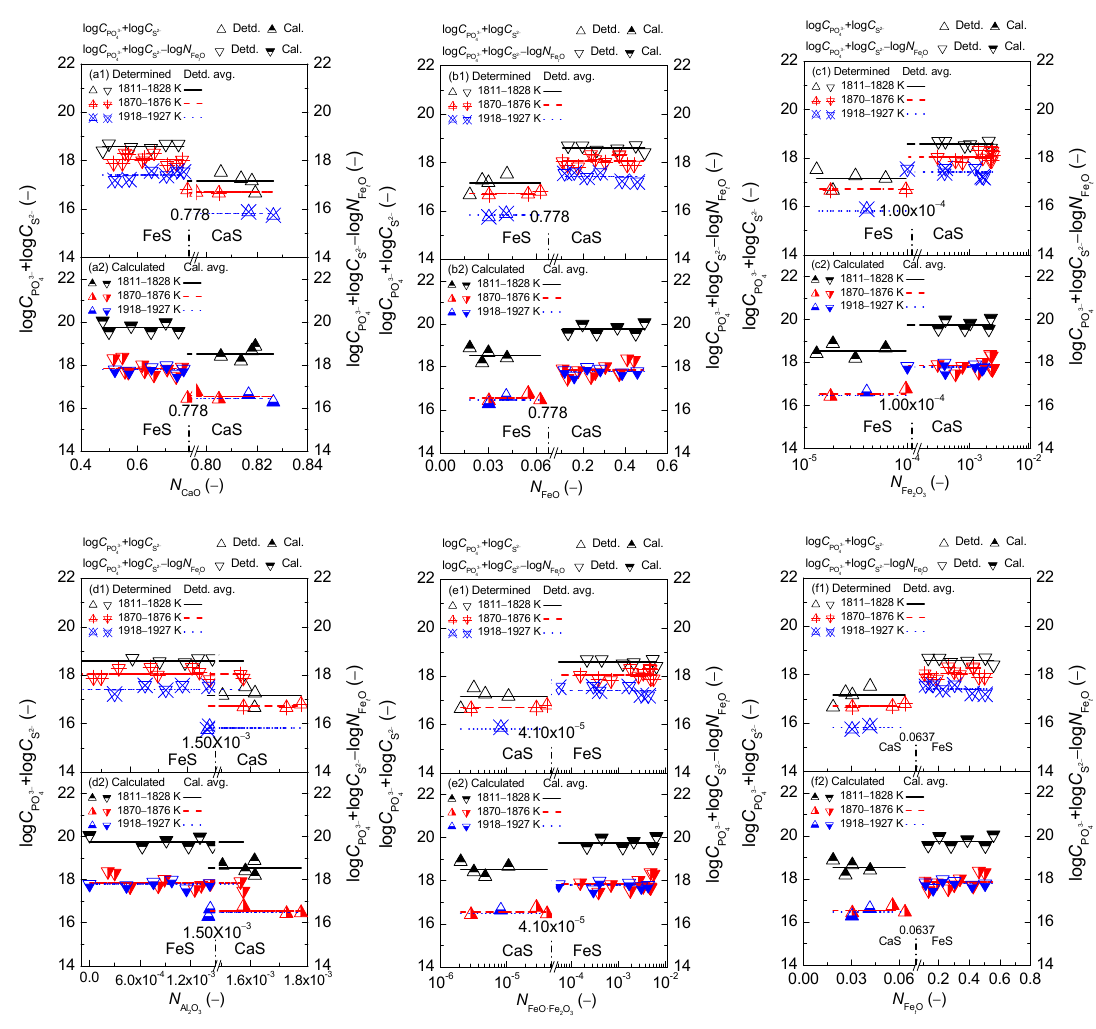
Figure 5. Relationship of calculated [3] mass action concentration N i of CaO ( a ), FeO ( b ), + Fe 2 O 3 ( c ), Al 2 O 3 ( d ), FeO · Fe 2 O 3 ( e ), and Fe t O ( f ) against determined term log C PO 3 − 4 , determined Figure 5 . Relationship of calculated [3] mass action concentration N of CaO (a), FeO (b), Fe 2 O 3 (c), i + log C − log N log C or log C FeO after Ban-ya et al. [1] in S 2 − , determined S 2 − , determined PO 3 − 4 , determined Al 2 O 3 (d), FeO·Fe 2 O 3 (e), and Fe t O (f) against determined term or + log C IMCT + the first layer or calculated term log C IMCT or log C IMCT PO 3 − 4 , calculated S 2 − , calculated PO 3 − 4 , calculated − log N log C IMCT FeO based on results from Yang et al. [3,5] in the second layer S 2 − , calculated based on results from Yang et al. [3,5] in the second layer for CaO–FeO–Fe 2 O 3 –Al 2 O 3 –P 2 O 5 slags equilibrated with liquid iron over a temperature range from 1811 to 1927 K (1538 to 1654 °C), respectively.